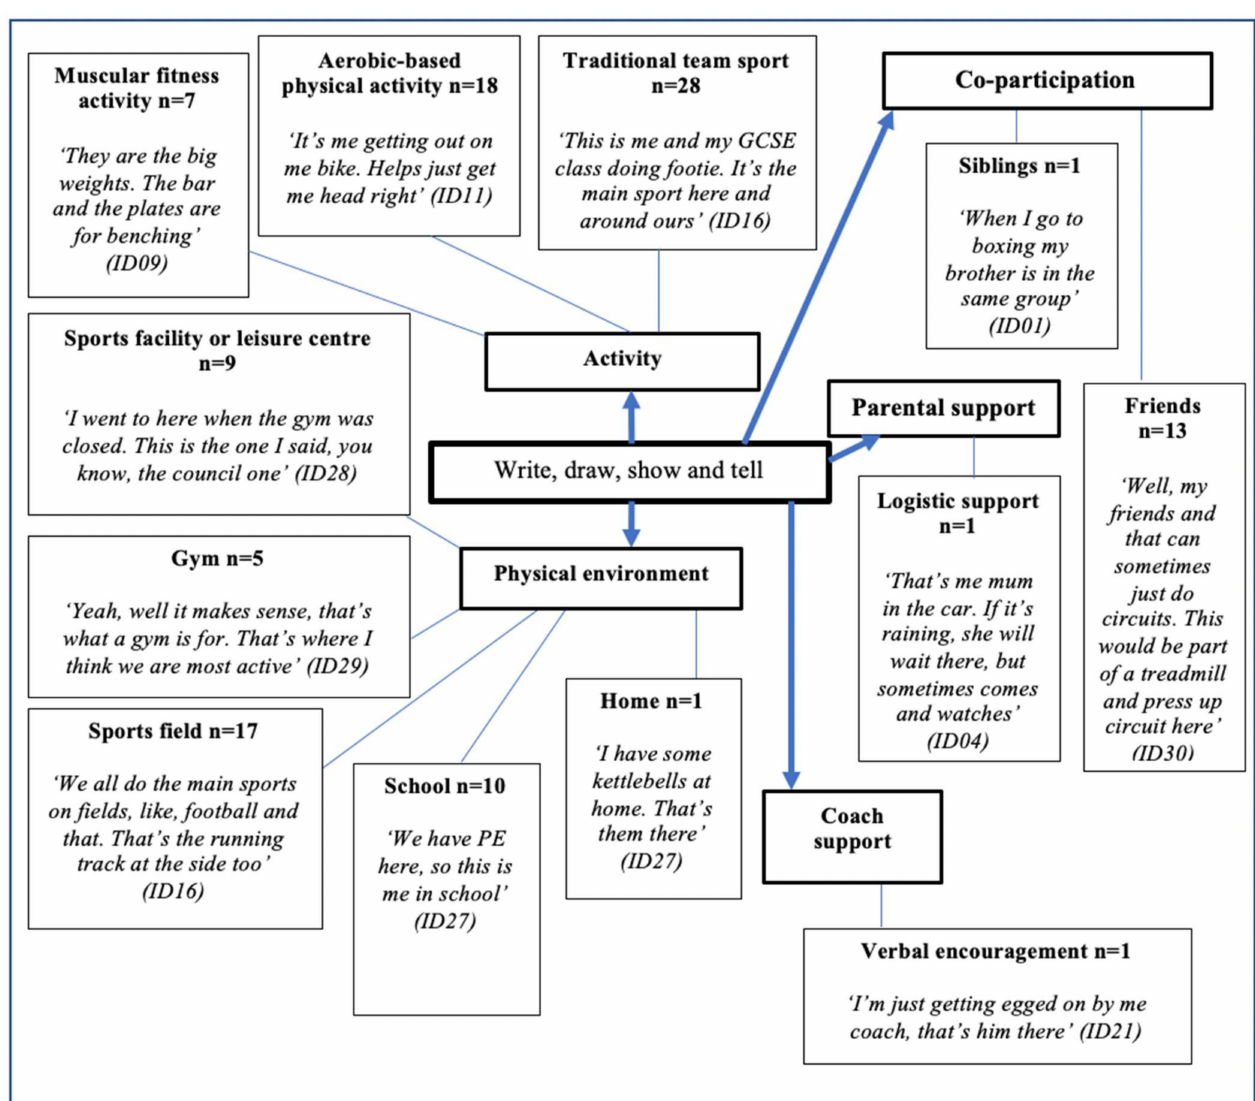
Figure 5. Write, draw, show, and tell. +ve = positive; − ve =